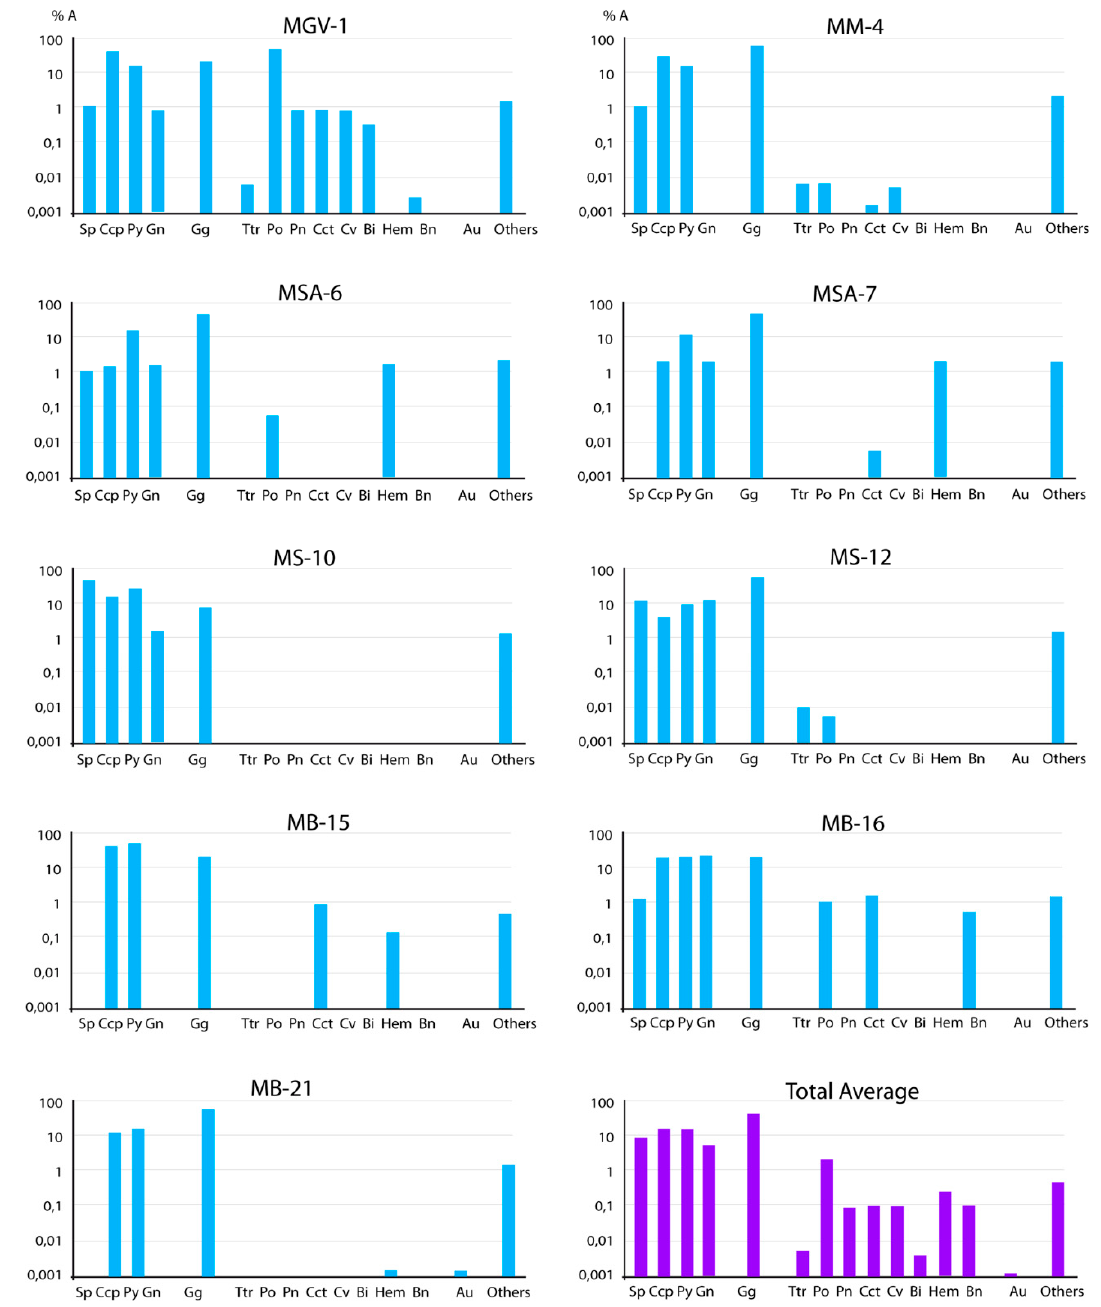
Figure 7. Histograms (log scale) showing modal analyses of nine polished sections by automated optical microscopy (CAMEVA System). Thirteen ore minerals (sphalerite, chalcopyrite, pyrite, galena, tetrahedrite, pyrrhotite, pentlandite, chalcocite, covellite, native bismuth, bornite, hematite, and gold) and gangue were quantified. Nine polished samples and estimated total